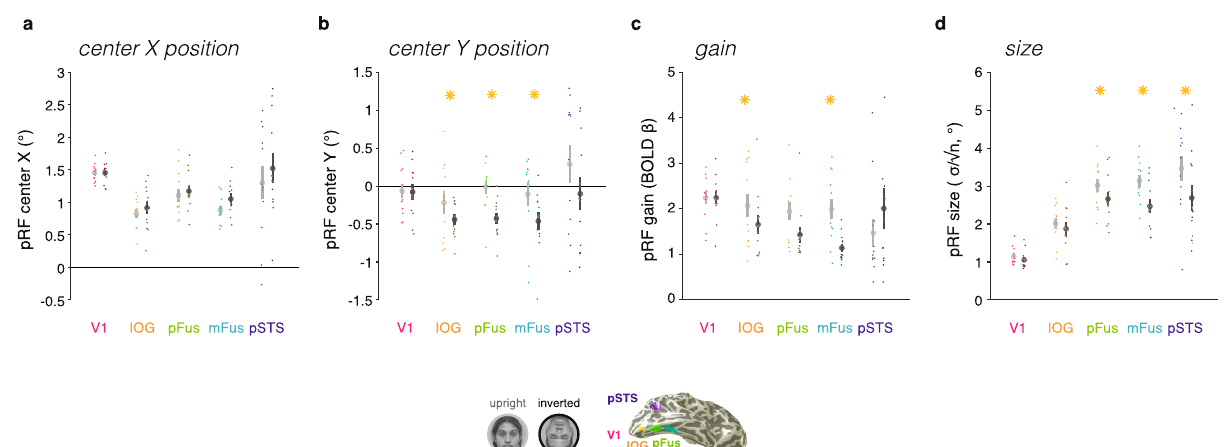
Fig. 2 Face inversion impacts pRF estimates in face-selective cortical areas but not primary visual cortex. Mean pRF parameters when mapped with upright faces (light gray) and inverted faces (dark gray) in bilateral regions of interest (ROIs). Gray markers: mean across 12 participants. Error bars: ±SEM across participants. Dots: individual participant means. Asterisks: statistically signi fi cant differences between upright and inverted-face mapping conditions (two-tailed paired post-hoc t -test across participants, p < .05 following analysis of variance (ANOVA); full statistics in Supplementary Table 1). a pRF center X° position; right hemisphere data are mirror fl ipped to left. b pRF center Y° position. c pRF gain. d pRF size ( σ ° ⁄ √